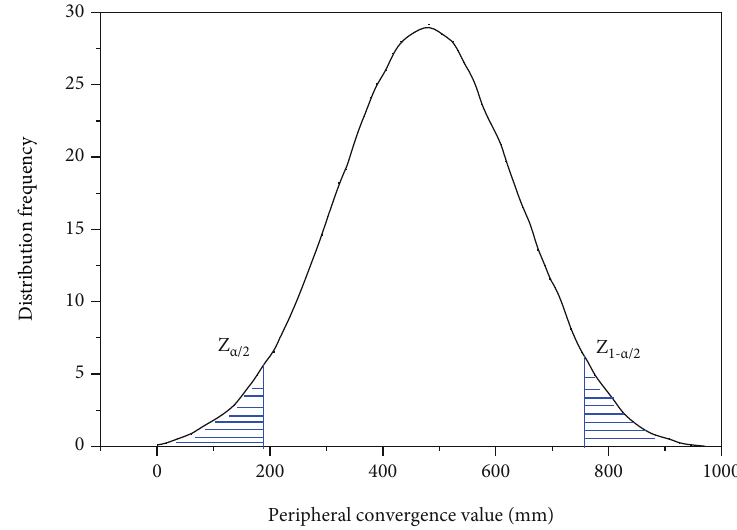
Figure 11: Schematic diagram of tunnel deformation interval